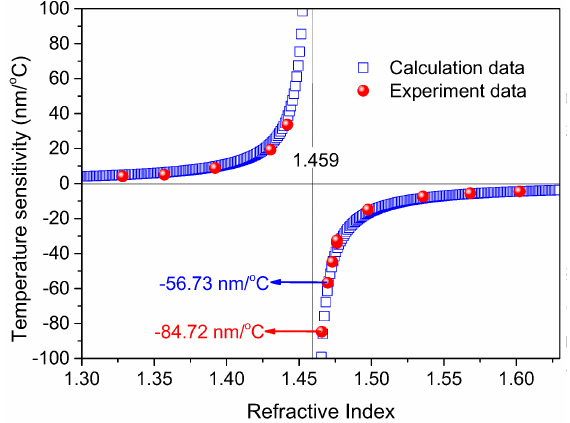
Figure 8. Comparison of theoretically calculated and experimentally acquired temperature sensitivities for the filled liquids with different